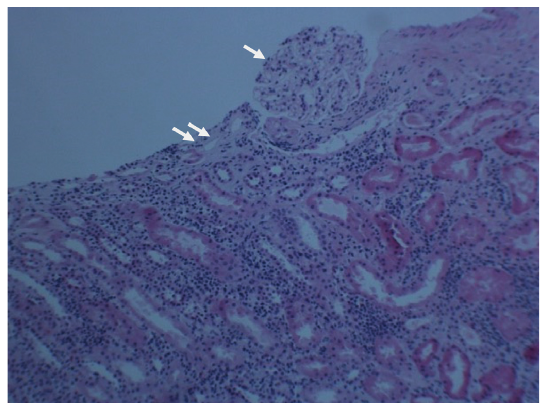
Figure 1: Hematoxylin and eosin staining (H&E) ∗ with 100 magnification. The image shows a normal glomerulus (single ar- row) and arteriole (double arrow) moderate tubulointerstitial in- flammation and